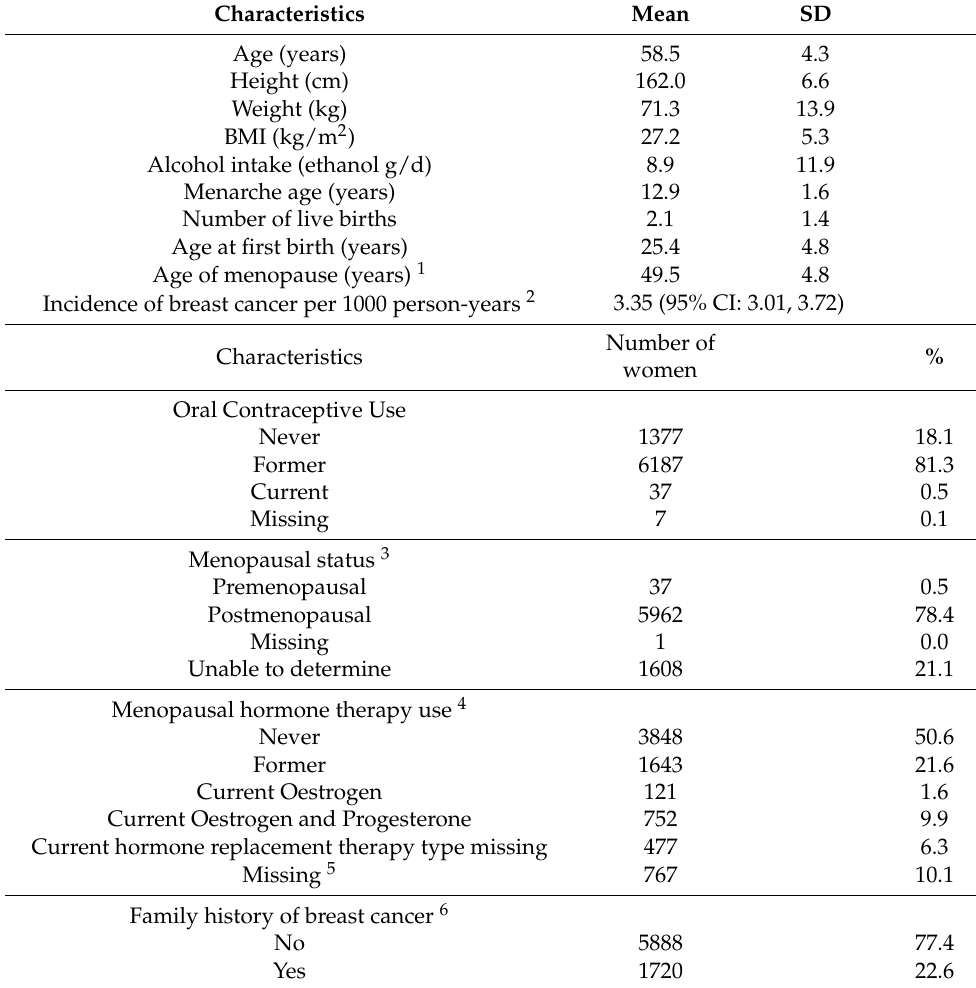
Table 1. Characteristics of the Melbourne Collaborative Cohort Study participants (aged 50–65